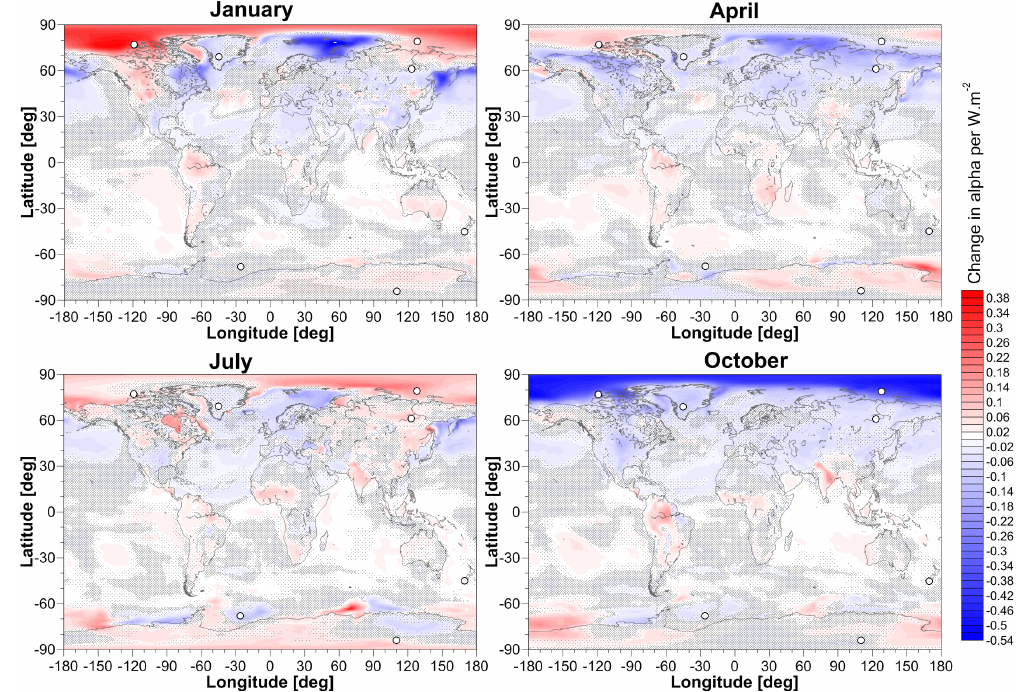
Fig. 9. The trend in α for T 0 max across the three RCP scenarios from which the α values were derived (see colour scale on right). Regions of dense stippling show where the trend is not statistically significantly different from zero at the 1 σ level and less dense stippling shows where the trend is significant at the 1 σ level but not at the 2 σ level. Unstippled regions show where the trend is significant at the 2 σ level. White dots show the location of the sites presented in Fig. 8.